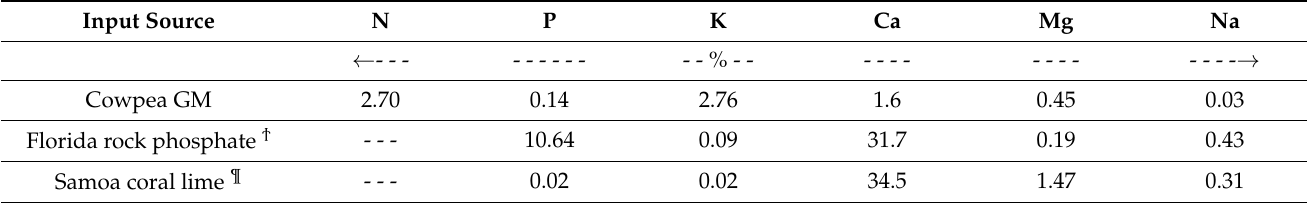
Table 1. Total nutrient contents of cowpea green manure, rock phosphate, and coral lime used in the experiment.